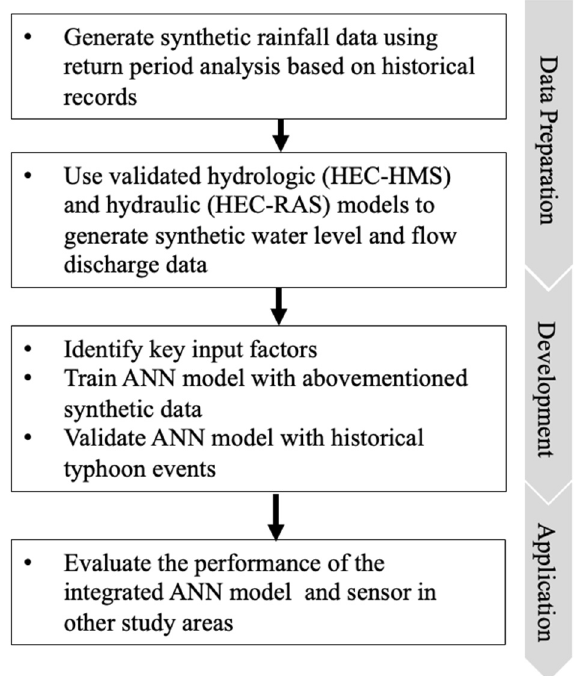
Figure 5. Research flowchart of the proposed ANN models.